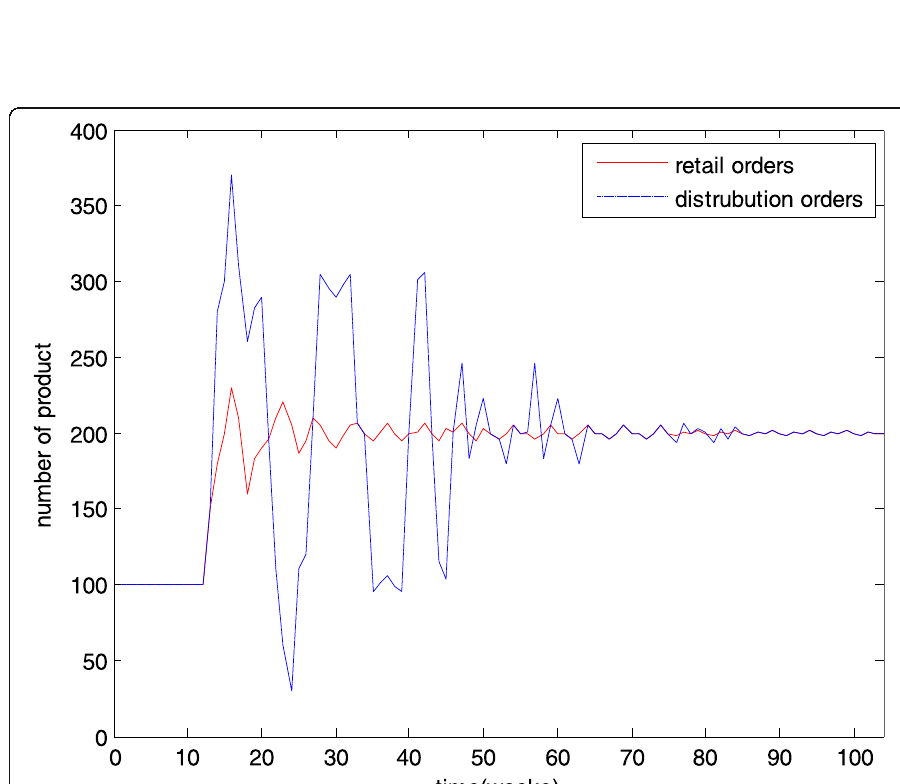
Fig. 7 Test results of the system dynamics model when the requirement is increased to